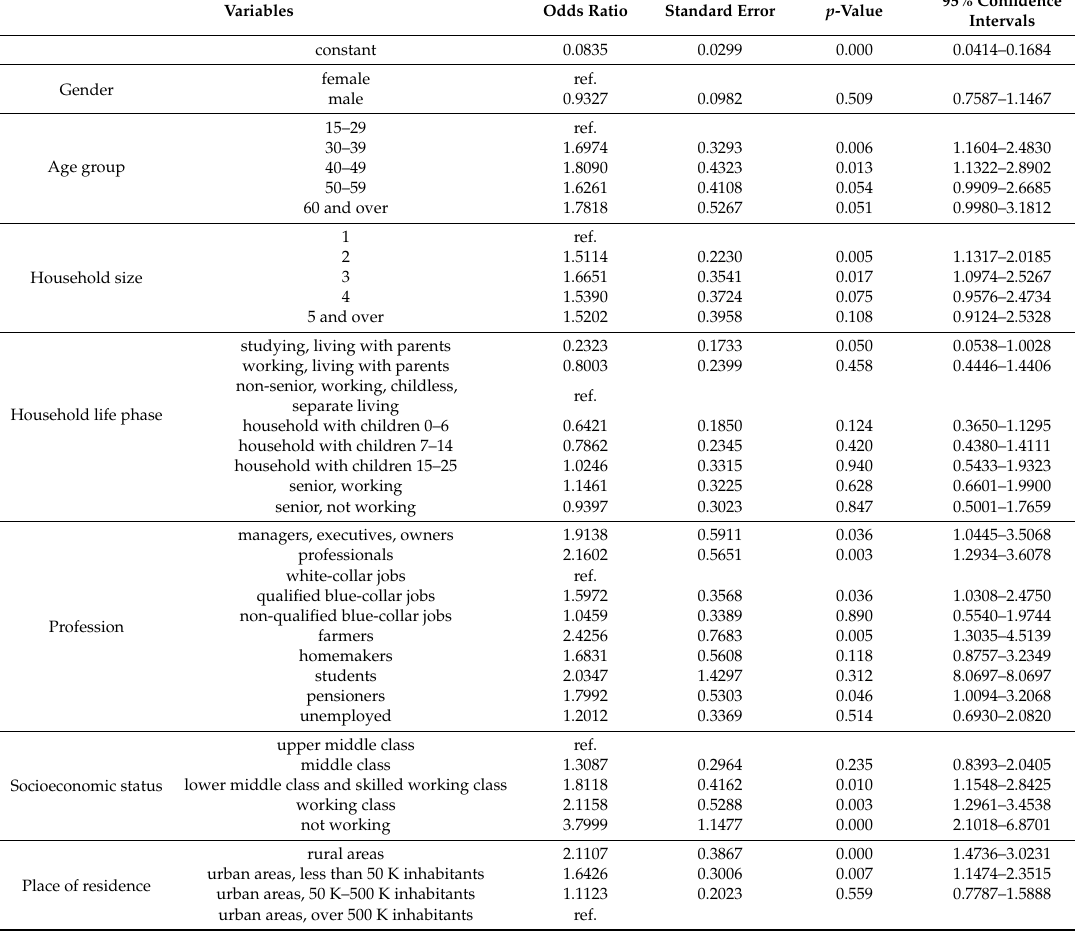
Table 3. Logit estimation of physical insufficient activity in